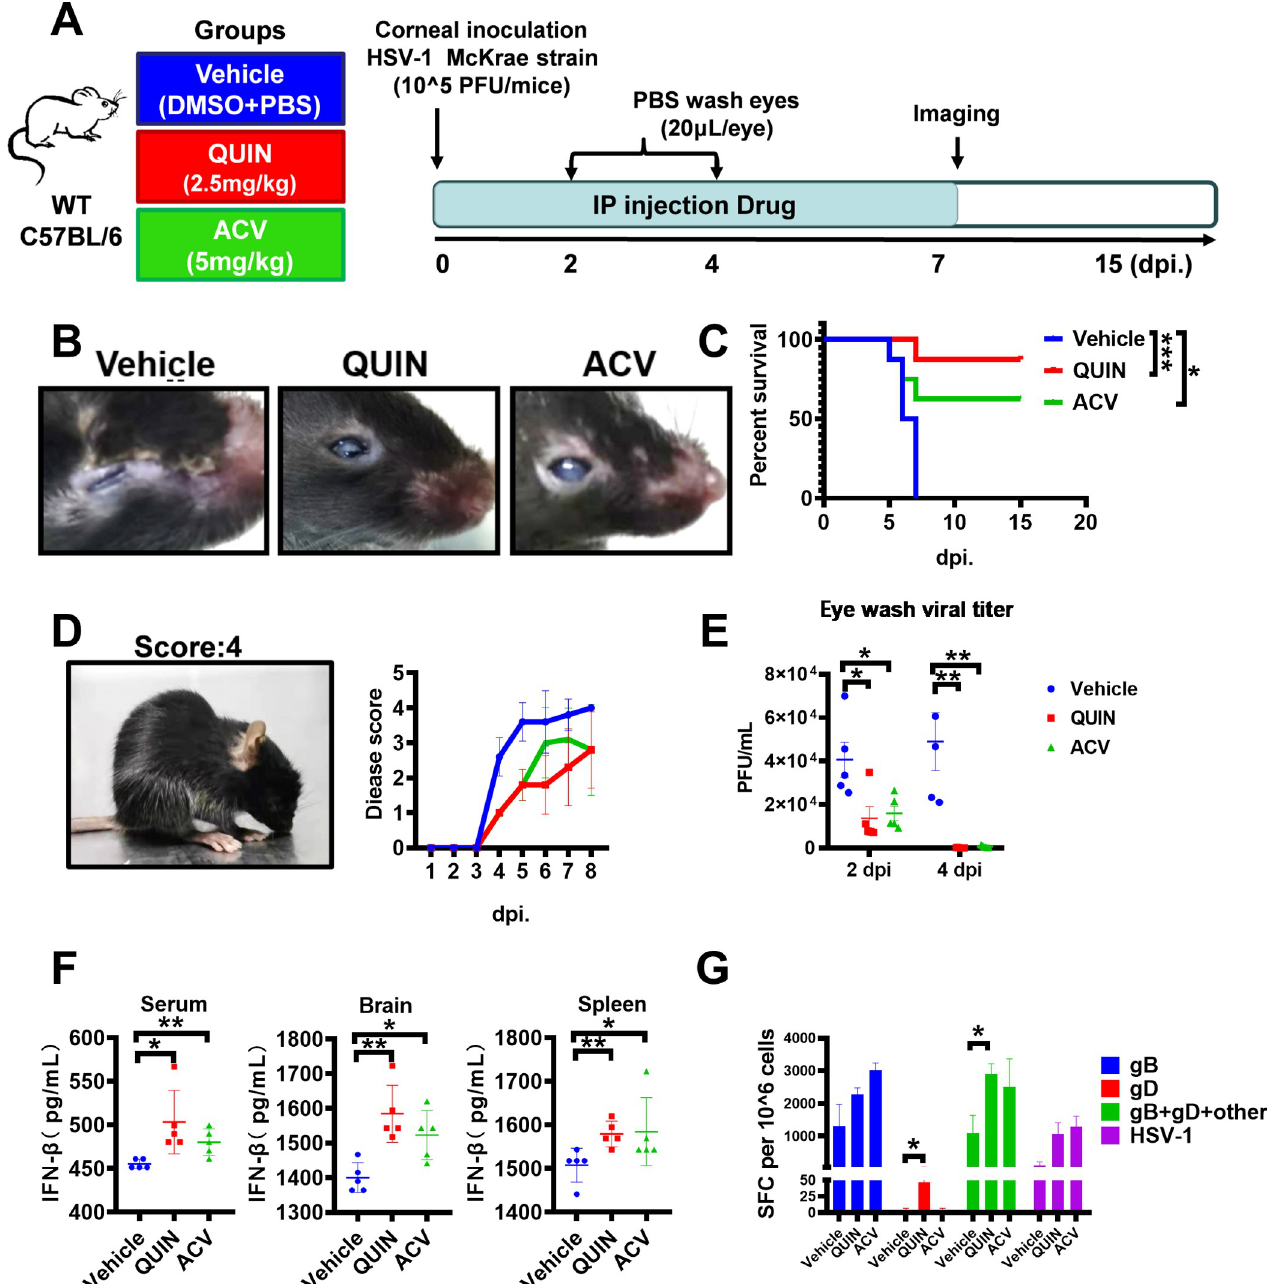
Fig 5. QUIN treatment protected mice from viral infections. (A) Schedule for evaluating the therapeutic efficacy of QUIN in mice. Briefly, C57BL/6 mice were corneally inoculated with 10 5 PFU HSV-1 McKrae strain and treated daily with QUIN for 7 days. The vehicle group (negative control) was received intraperitoneal (IP) injection of DMSO and PBS. QUIN group was received an IP injection of QUIN (2.5 mg/kg). The ACV group (positive control) received an IP injection of ACV (5 mg/kg). The eyes of mice were washed at 2 dpi and 4 dpi to perform the plaque assay. The disease symptoms of experimental mice were monitored until 15 dpi. (B) The representative picture of progressive corneal scarring, visual impairment of experimental mice in different groups at 7 dpi. (C) Survival curve of experimental mice in different groups over time post-infection (n = 8). (D) Statistical analysis of disease scores of experimental mice in different groups over time (n = 5). Score 0, healthy; Score 4, being severe disease. (E) The HSV-1 titer in the eye washing fluid at 2 dpi and 4 dpi were measured by plaque assay (n = 5 per group). (F) The concentration of IFN- β in serum, brain, and spleen of experimental mice at 5 dpi was measured by ELISA assay (n = 5 per group). (G) The frequency of HSV-1 antigen-specific IFN- γ -secreting cells was determined by the enzyme-linked immunosorbent spot (ELISPOT) assays at 5 dpi. Data represents spot-forming cells (SFC) per million cells. The final data are presented as the mean ± SD of triplicate experiments. � P < 0.05, �� P < 0.01, ��� P <